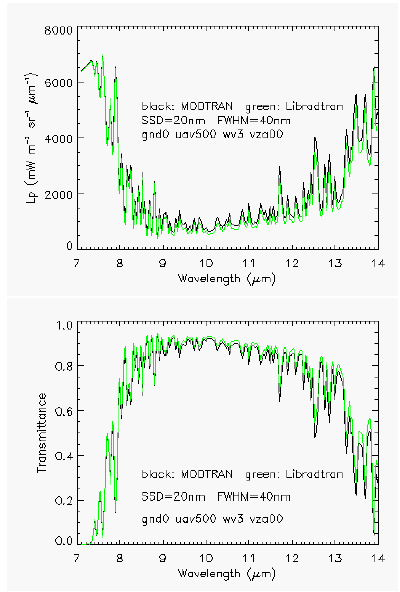
Figure 1. Comparison of MODTRAN and Libradtran simulations of exemplary atmospheric influence functions in the TIR ( L p : path radiance and τ transmittance).